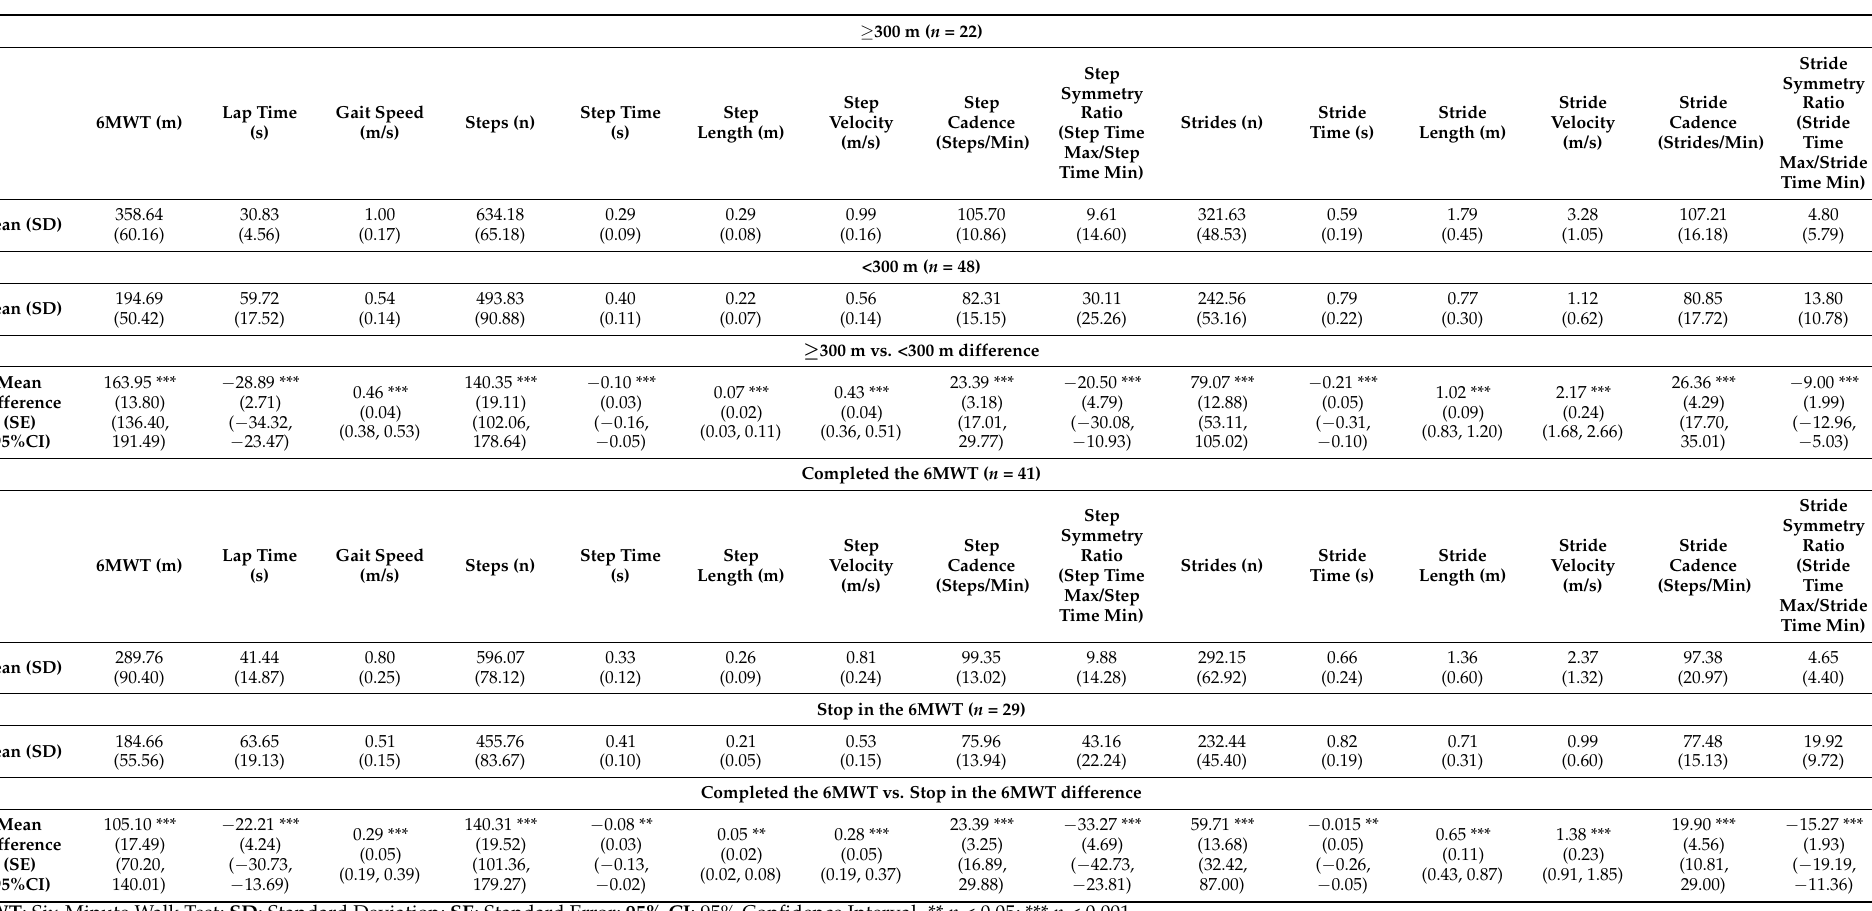
Table 2. Kinematic gait parameters differences between the ≥ 300 m and <300 m groups in the 6MWT and between patients who completed the 6MWT and patients who could not finish the